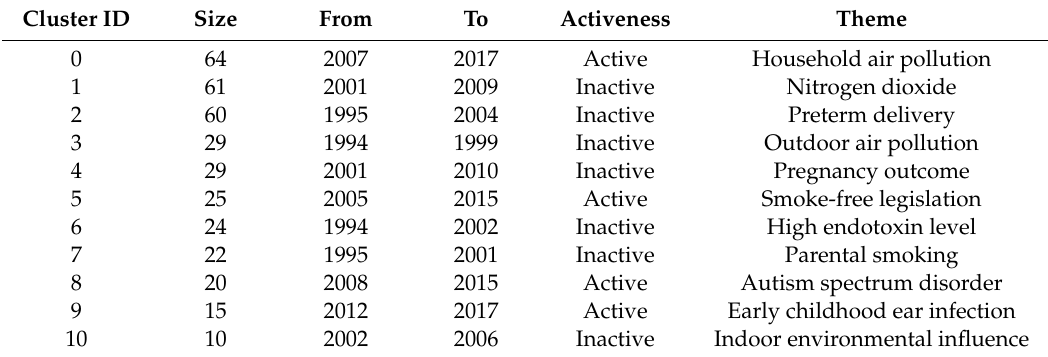
Table 3. Cluster analysis of literature from 1999–2018.